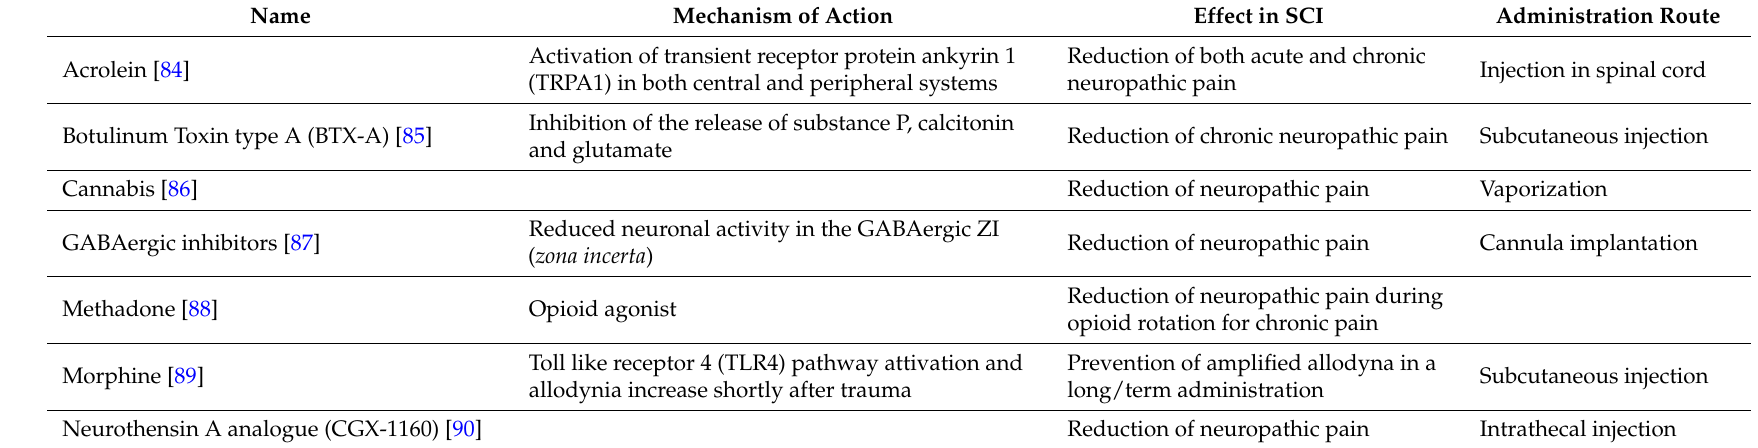
Table 4. Drugs with a neuropathic-pain target, reported in the literature over the last two years as potentially effective in the treatment of